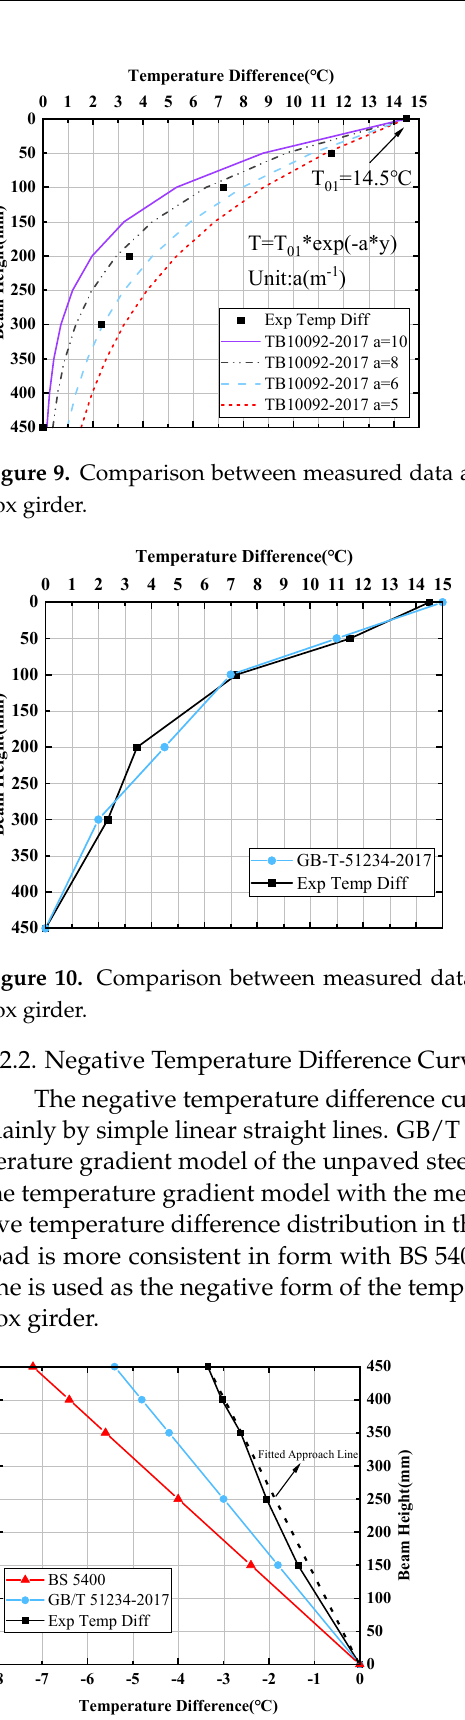
Figure 11. Comparison of negative temperature difference curves of the steel box girder.